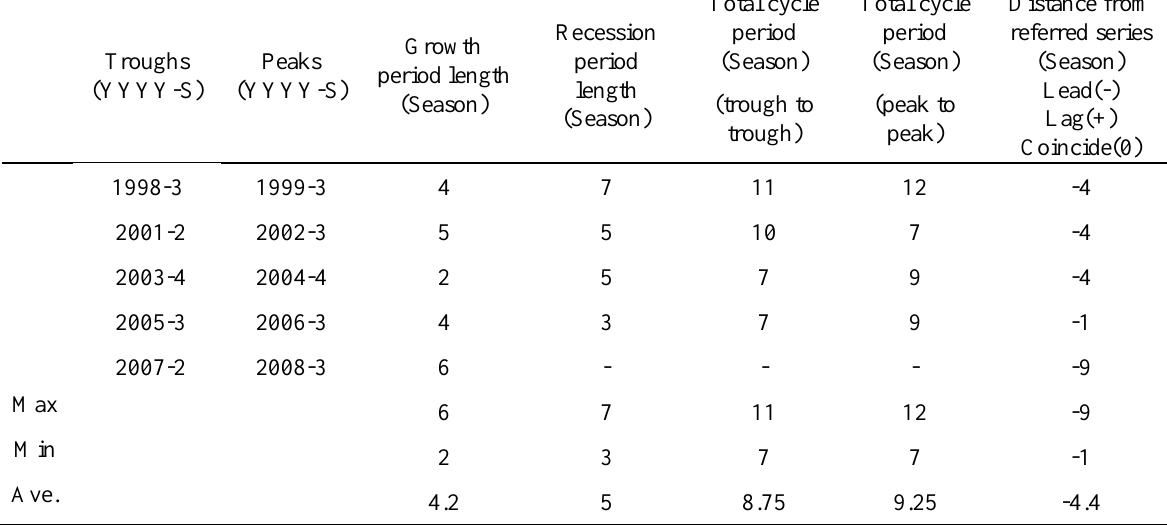
Table 1 . Turning points of Production price index and its comparison with reference series